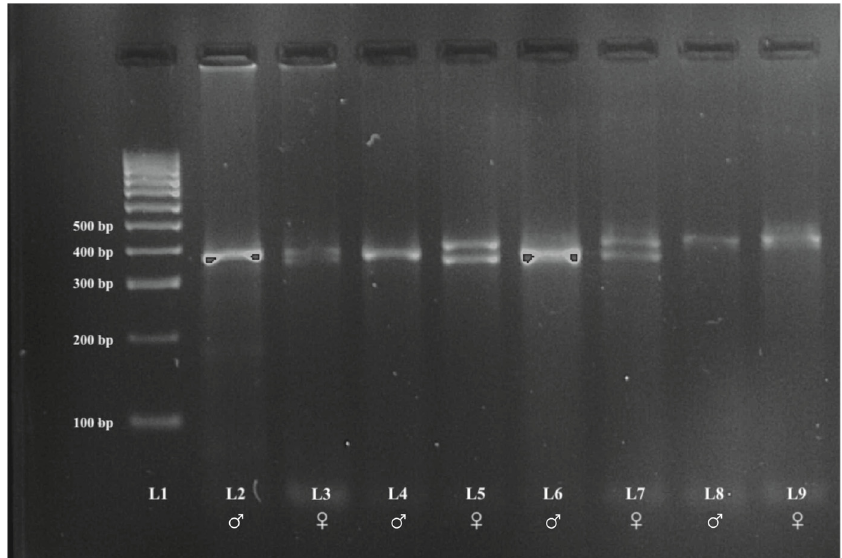
Figure 2. PCR results from oral swabs samples. Legend: L1—Size standard (100-bp DNA ladder), ♂ —male, ♀ —female, L2 and L3 Domestic Pigeons ( Columba livia domestica ), L4 and L5 Scarlet-chested Parrots (Neophema splendida ), L6 and L7 Rose-ringed Parakeets ( Psittacula krameri ), L8 and L9 Lovebirds ( Agapornis spp.).